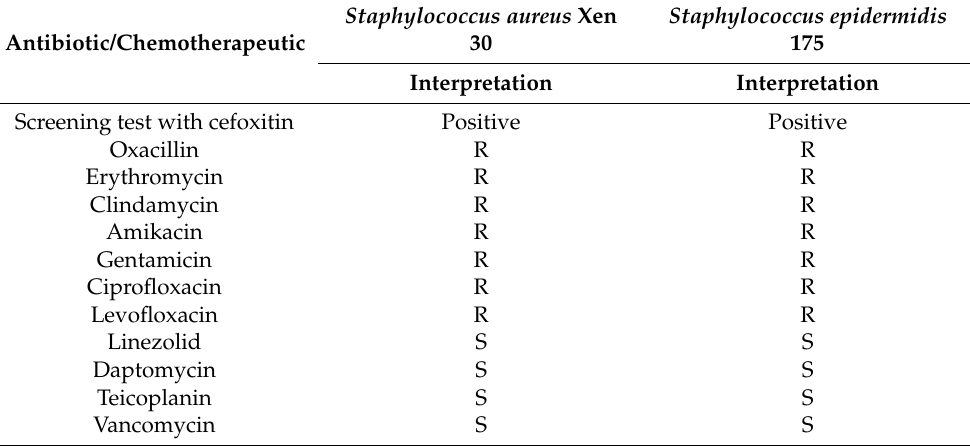
Table 2. Antibiotic susceptibility of Staphylococcus aureus Xen 30 and Staphylococcus epidermidis 175.